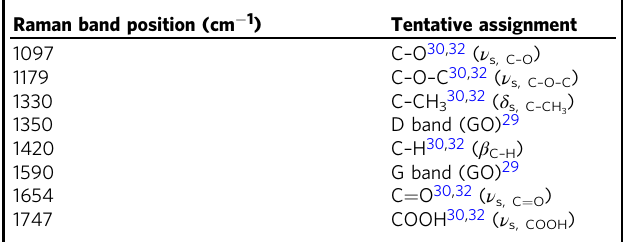
Table 1 Proposed assignment of Raman bands observed in the TERS spectra in Fig. 2b